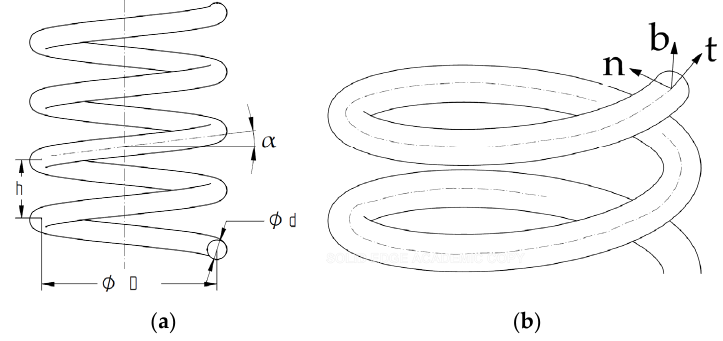
Figure 3. Helical spring: ( a ) geometrical parameters; ( b ) Frenet trihedral.